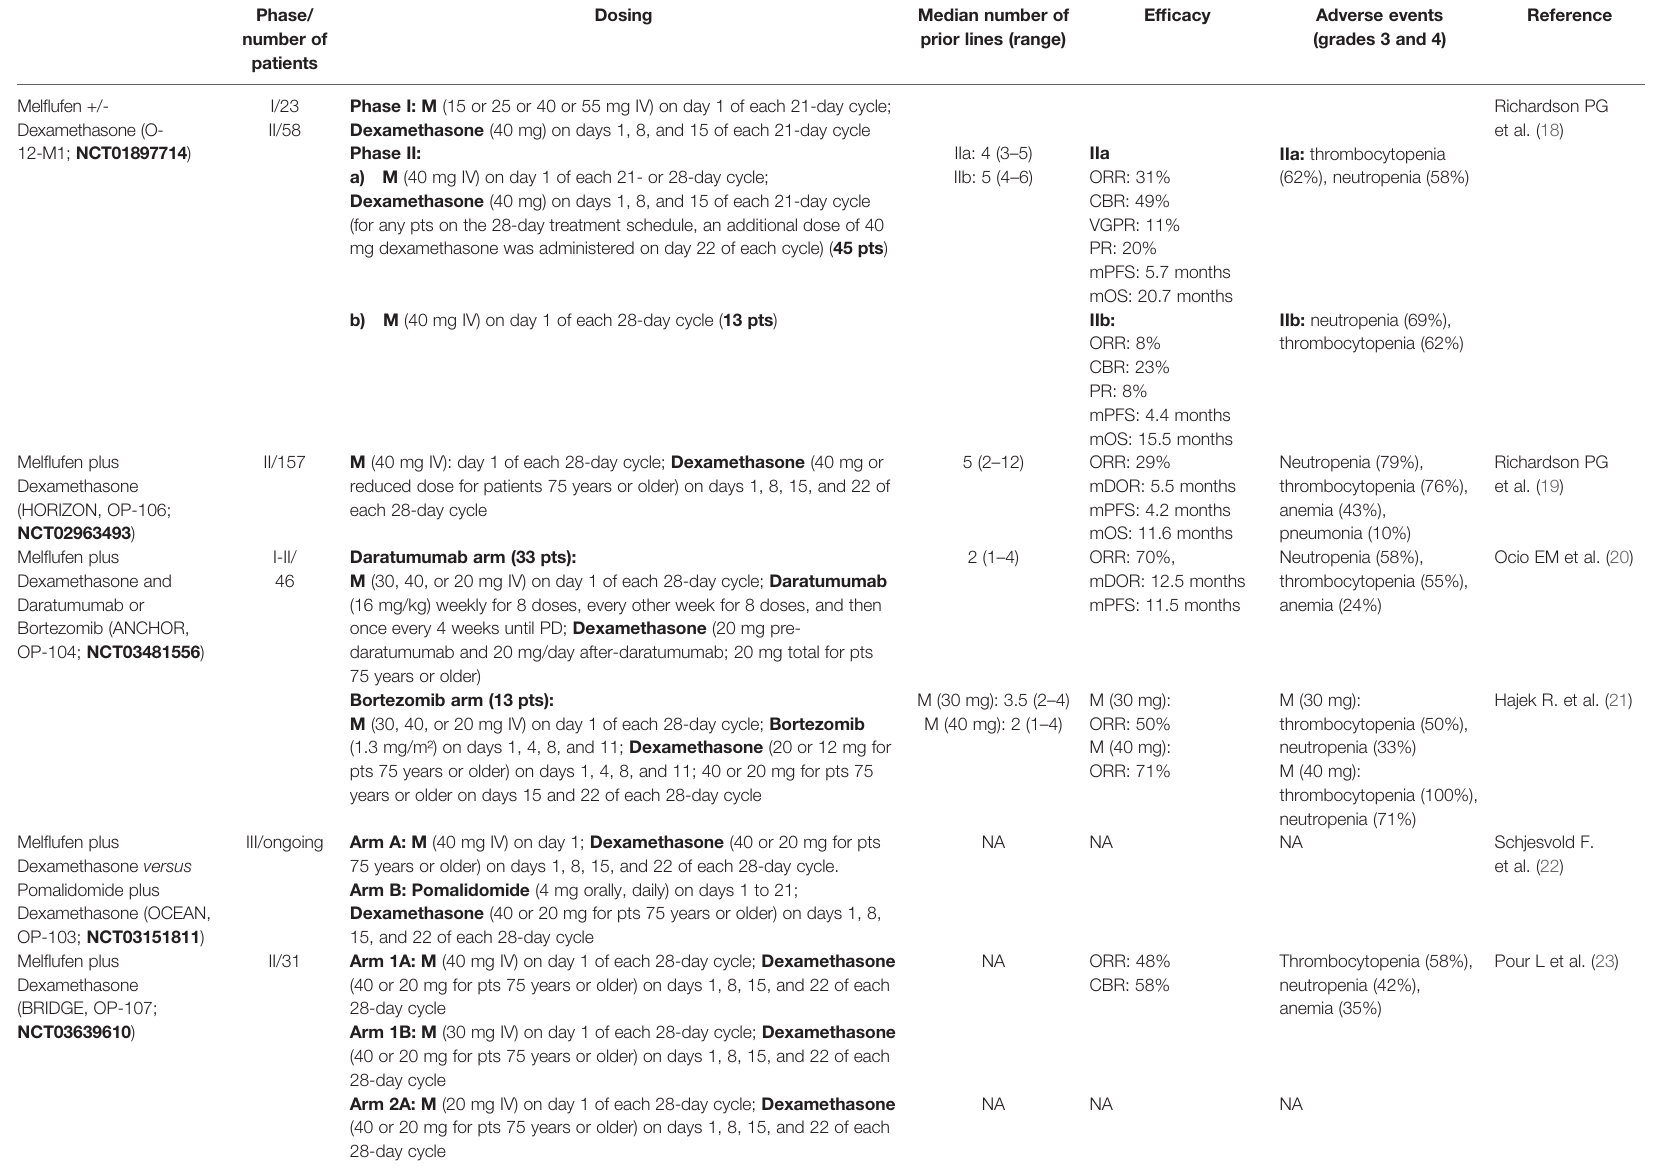
Dosing Median number of